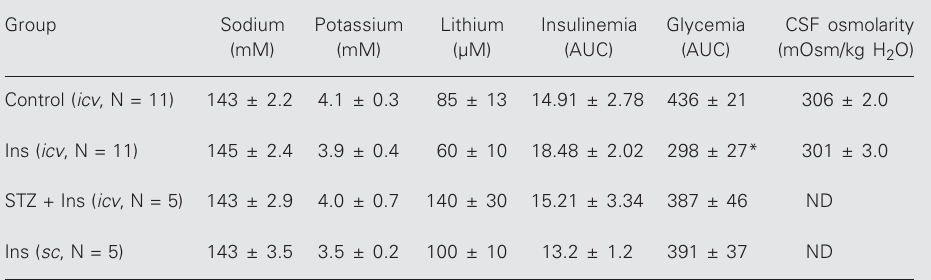
Table 1. Effect of intracerebroventricular ( icv ) and subcutaneous ( sc ) insulin (Ins, 42 ng/µl) or icv NaCl injection (control, 0.15 M) in sham-operated rats on cerebrospinal fluid (CSF) osmolarity, serum sodium, potassium and lithium levels, and insulinemia and glycemia compared to the administration of insulin (STZ + Ins, 42.0 ng/µl) in streptozotocin-treated